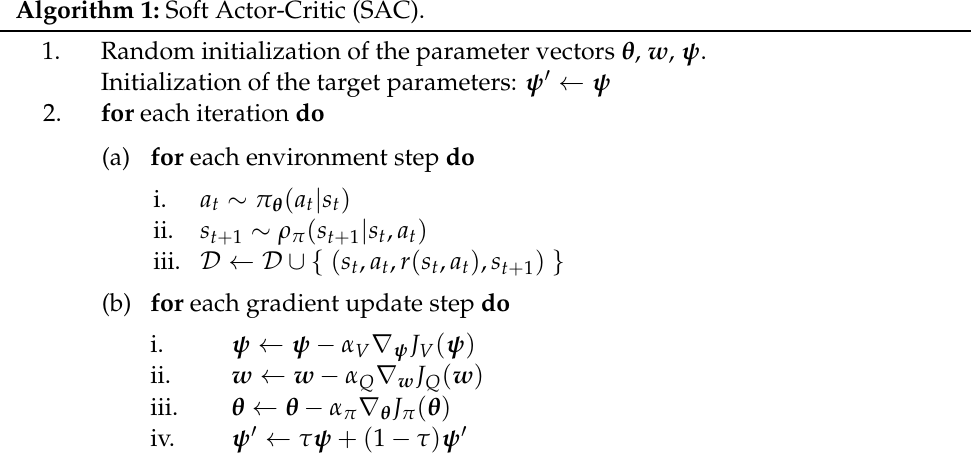
Algorithm 1: Soft Actor-Critic